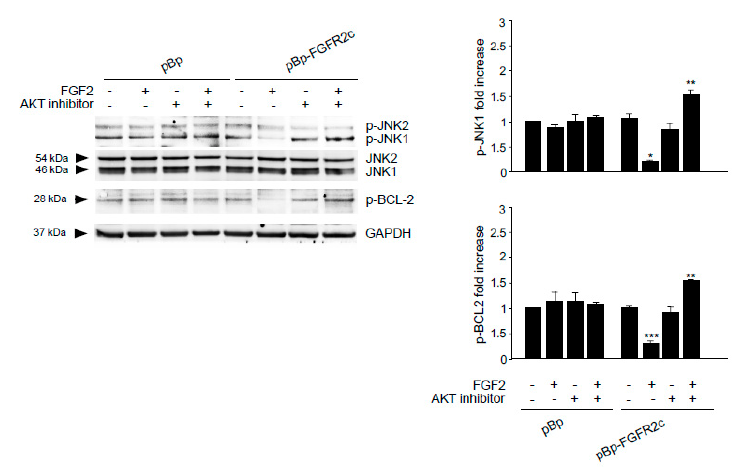
Figure 5. AKT signaling is required for FGFR2c-mediated inhibition of JNK e BCL-2 phosphorylation. HaCaT pBp and HaCaT pBp-FGFR2c clones were left untreated or stimulated with FGF2 in the presence or absence of AKT inhibitor as reported in Materials and Methods. Western blot analysis performed using antibody directed against the phosphorylated form of JNK and BCL-2, demonstrated that FGF2 stimulation decreases the basal phosphorylation of both substrates, while AKT inhibitor reverses this e ff ect. Densitometric analysis and the student’s t test were performed as reported in the legend to Figure 1A. * p < 0.05 and *** p < 0. 01 vs the corresponding FGF2-unstimulated cells; ** p < 0.05 vs the corresponding AKT inhibitor-untreated cells.